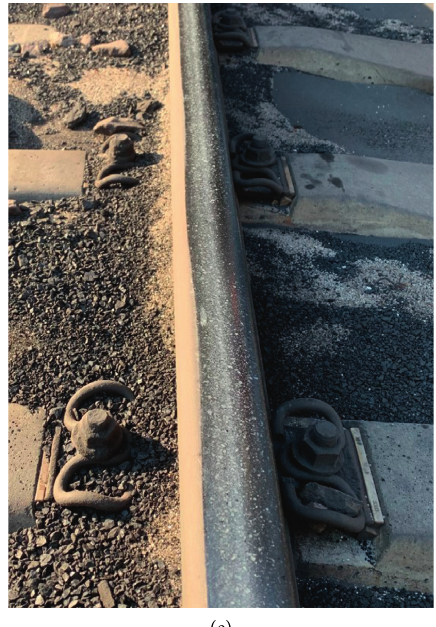
Figure 14: The actual corrugation situation for the corrugation sections in the testing samples. The pictures (a)–(e) show the corrugation situation for the testing Section 1 to Section 5.